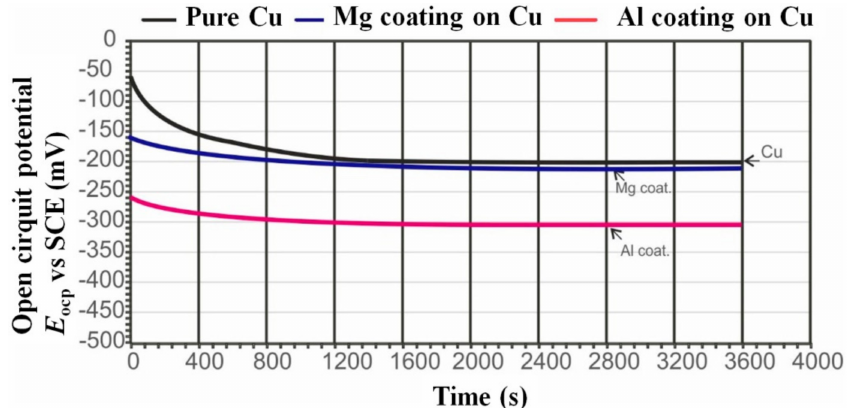
Figure 11. Open circuit potential (OCP)curves of uncoated and coated samples in 3.5 wt.% NaCl solution at 25 ◦